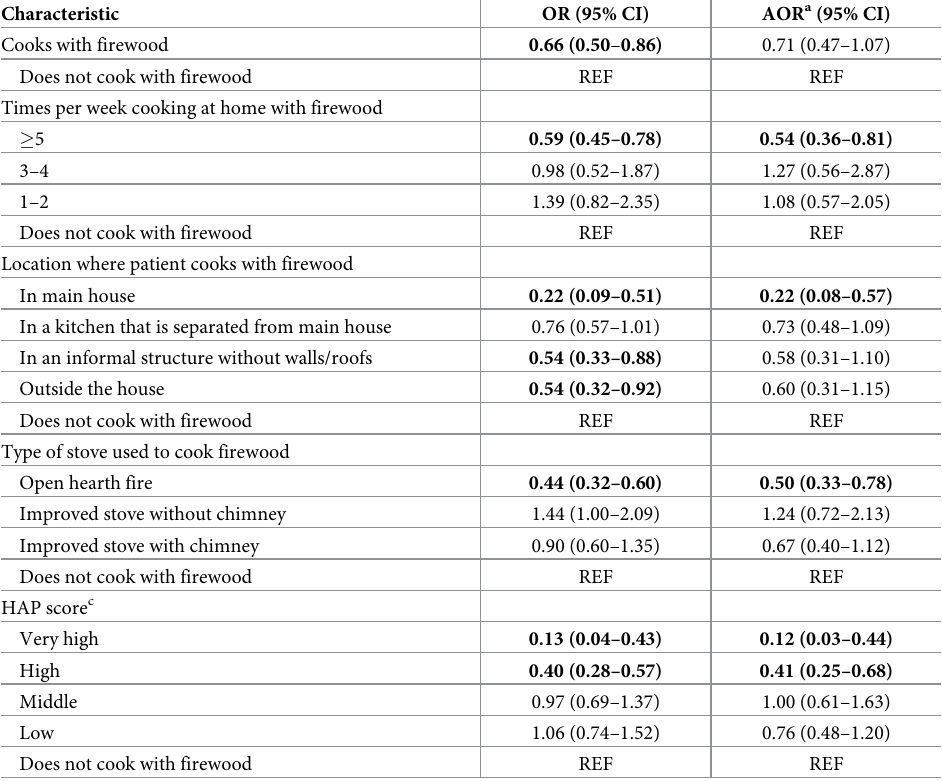
Table 3. Unadjusted and adjusted a associations between arboviral infection (dengue, chikungunya, or Zika virus) and indicators of household air pollution exposure, Santa Rosa, Guatemala, 2011–2018 (N = 311 cases and 1,239 controls b